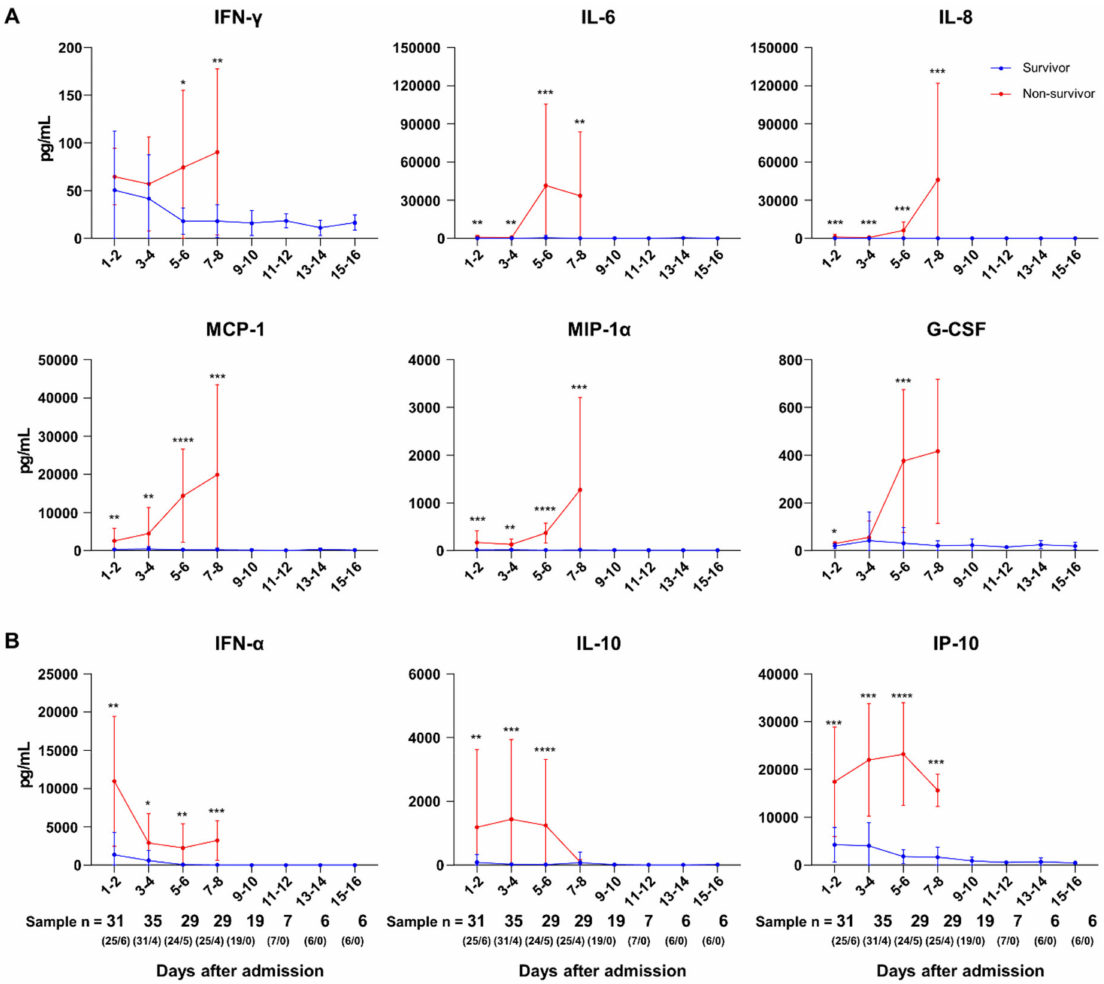
Figure 3. Plasma concentrations of cytokines and chemokines in patients with SFTS. IFN- γ , IL-6, IL-8, MCP-1, MIP-1 α , and G-CSF levels gradually increased during hospitalization ( A ), whereas IFN- α , IL-10, and IP-10 levels decreased or did not change ( B ). The numbers of analyzed samples were as follows: HD 1–2, n = 31 (survivor/non-survivor, 25/6); HD 3–4, n = 35 (31/4); HD 5–6, n = 29 (24/5); HD 7–8, n = 29 (25/4); HD 9–10, n = 19 (19/0); HD 11–12, n = 7 (7/0); HD 13–14, n = 6 (6/0); HD 15–16, n = 6 (6/0). * p < 0.05, ** p < 0.01, *** p < 0.001, **** p <